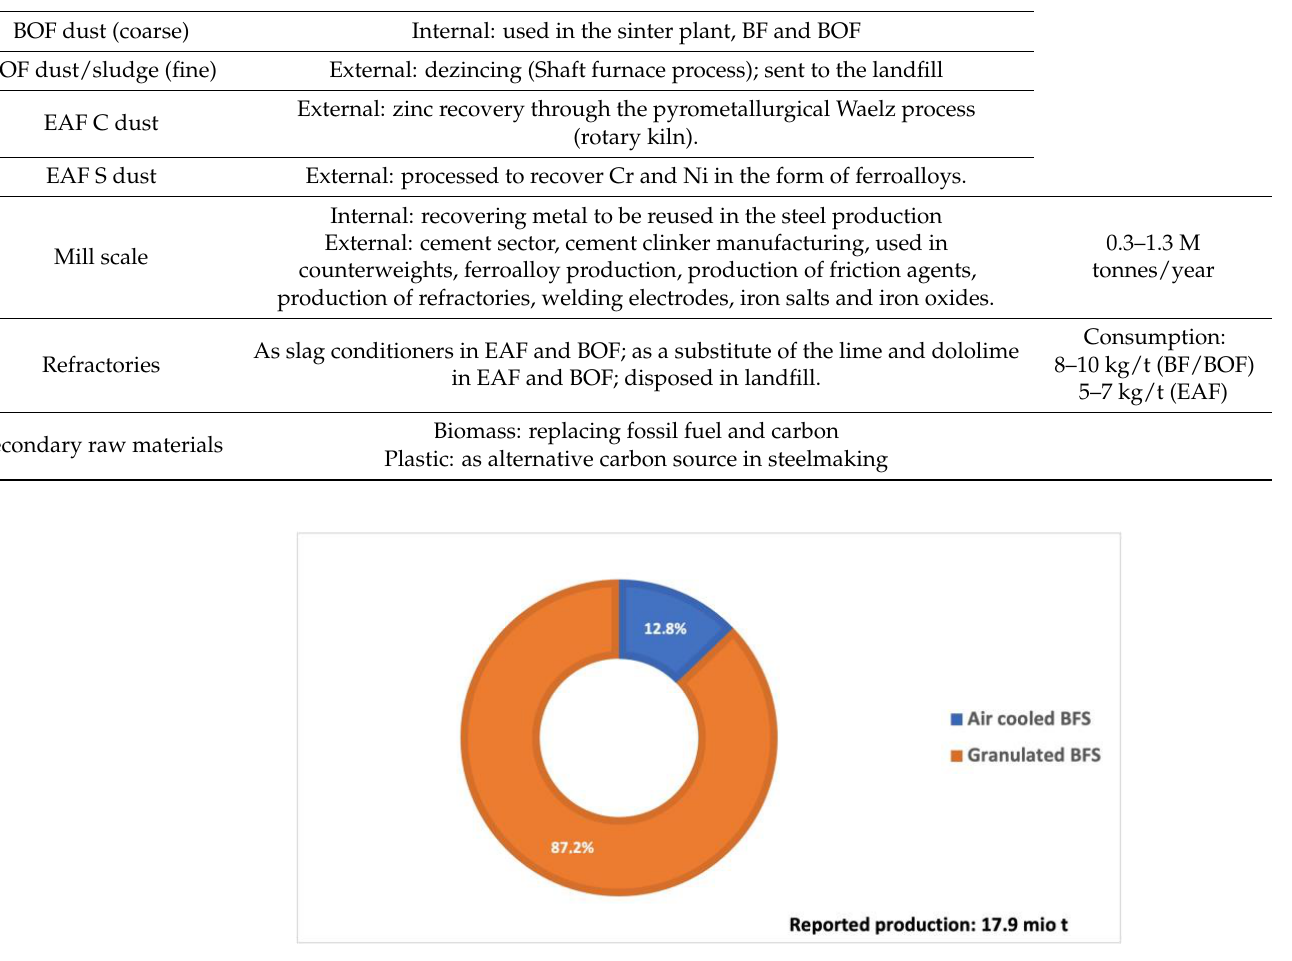
Figure 1. Production of BF slag in Europe in 2021 [4].